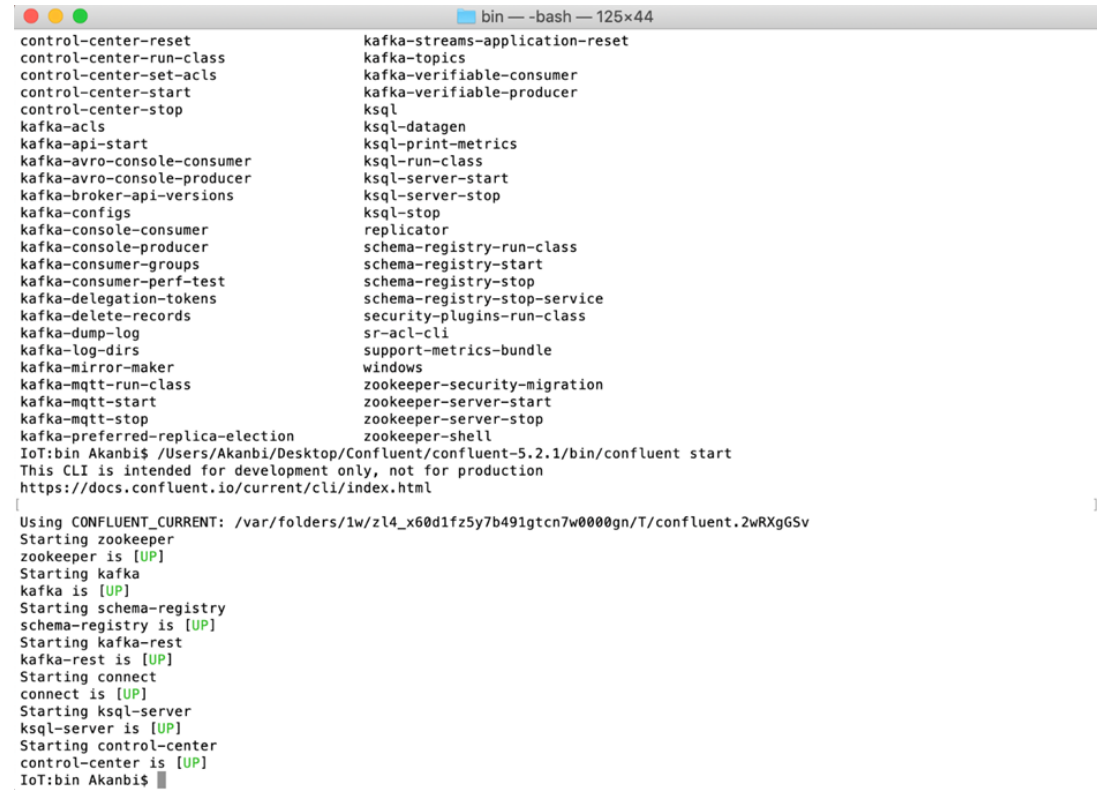
Figure 9. Starting Confluent Platform in the